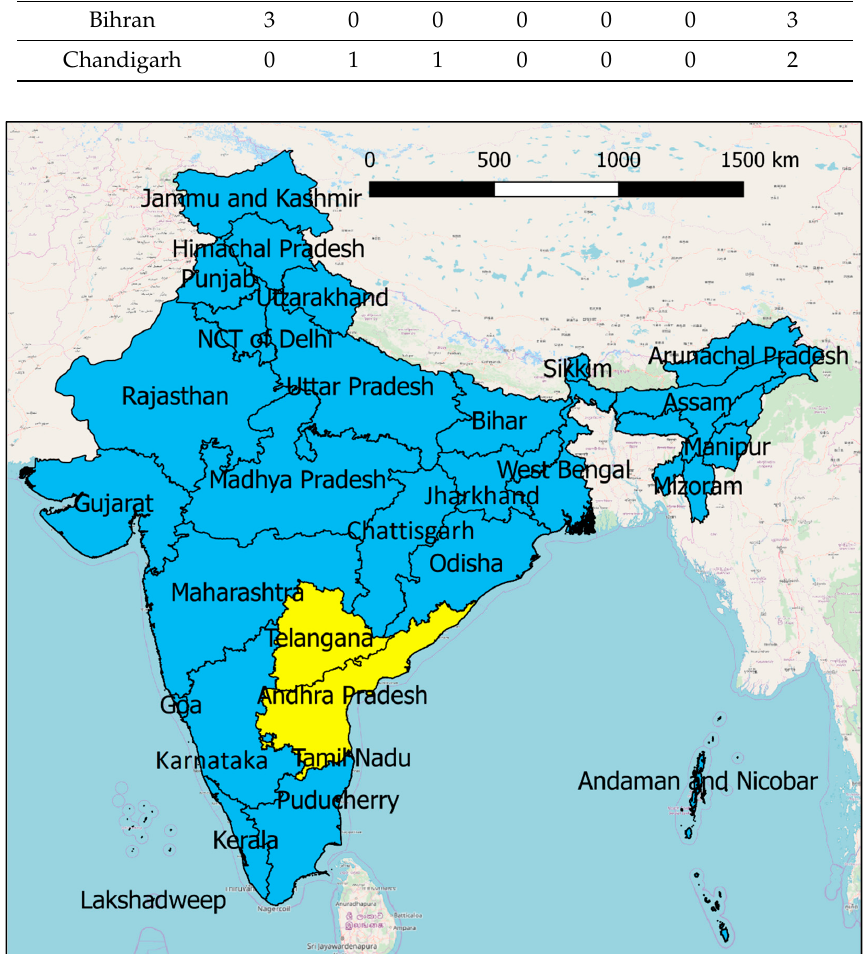
Figure 2. Indian states. The two selected for the regional analysis being the most affected by heat waves in the study period, Andhra Pradesh and Telangana, are highlighted in the figure.